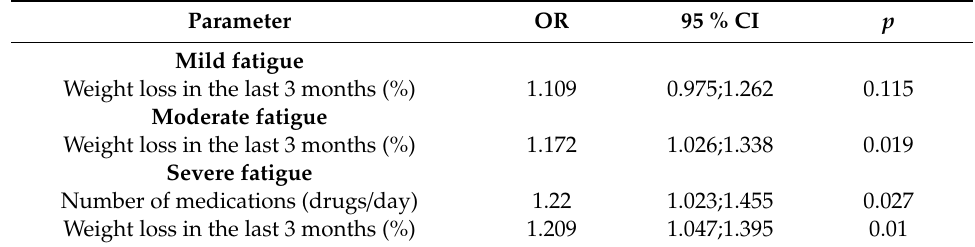
Table 3. Risk factors for severity of fatigue identified by multinomial regression analyses in patients with self-reported weight loss (model 1).